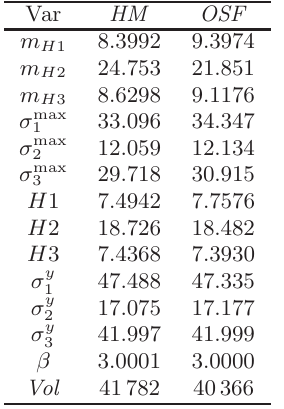
Table 5. Results of the OSF and